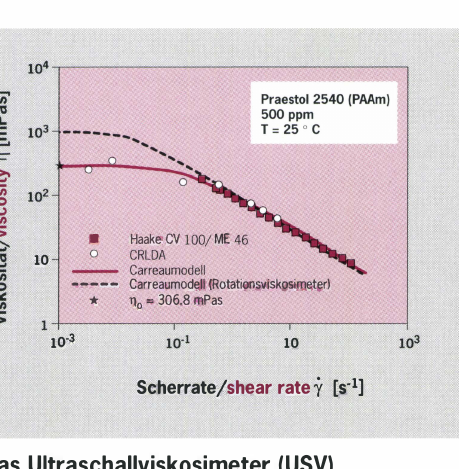
Erster MeBpunktjfirst measuring poi nt